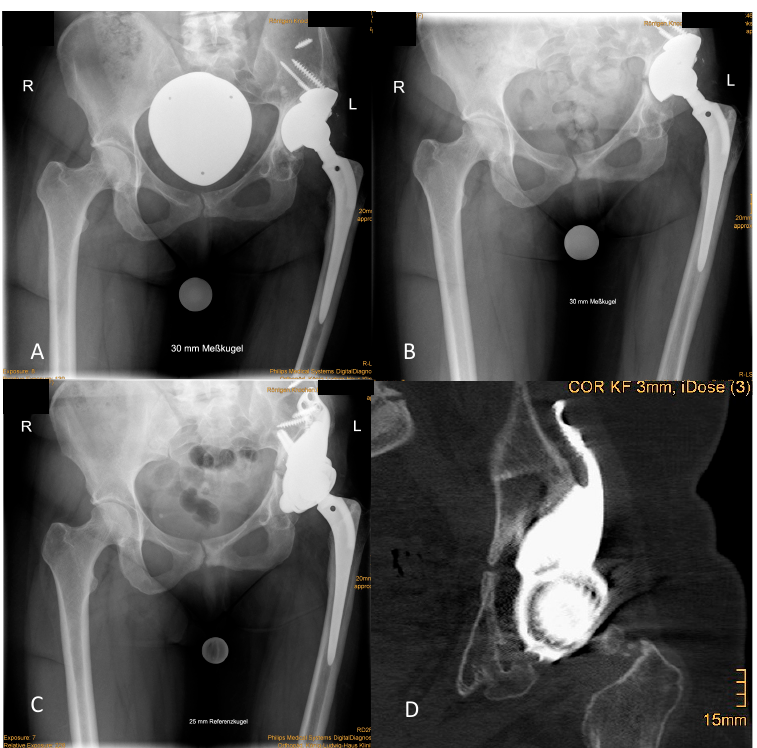
Figure 4. Osteointegration of the socket at follow-up. ( A ) Preoperative situation demonstrated an “up and out” defect that was filled by the loosened cup and augment construct. ( B ) The radiographic control after 2 years displayed PD with complete disruption of the ilio-ischial line and medial protrusion of the cup. ( C ) Radiographic situation 2 years after revision showed no sign of loosening. ( D ) In the CT, spot welds, as sign of osteointegration at the HA-coated socket, were seen.